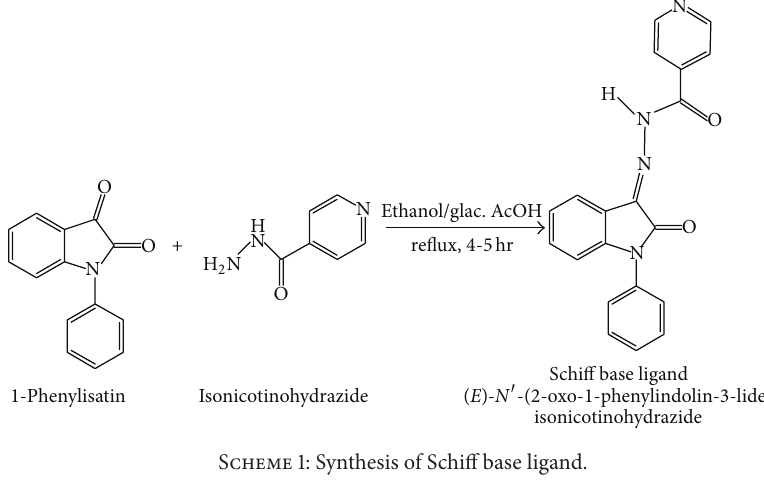
Scheme 1: Synthesis of Schiff base ligand.